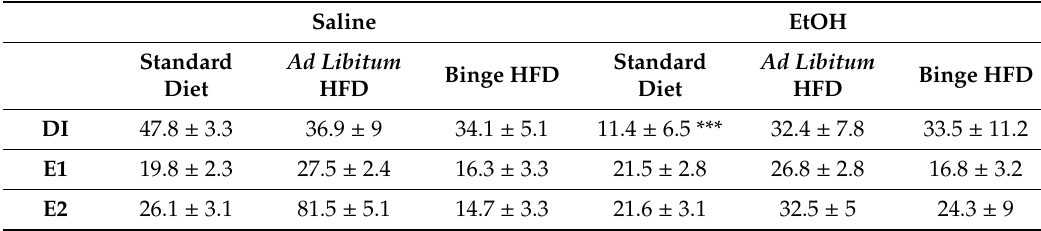
Table 3. Object recognition. Data are presented as mean ( ± SEM), *** p < 0.001 with respect to corresponding saline group. DI: discrimination index; E1 and E2: measures of the total exploration time of both objects during test 1 and test 2,